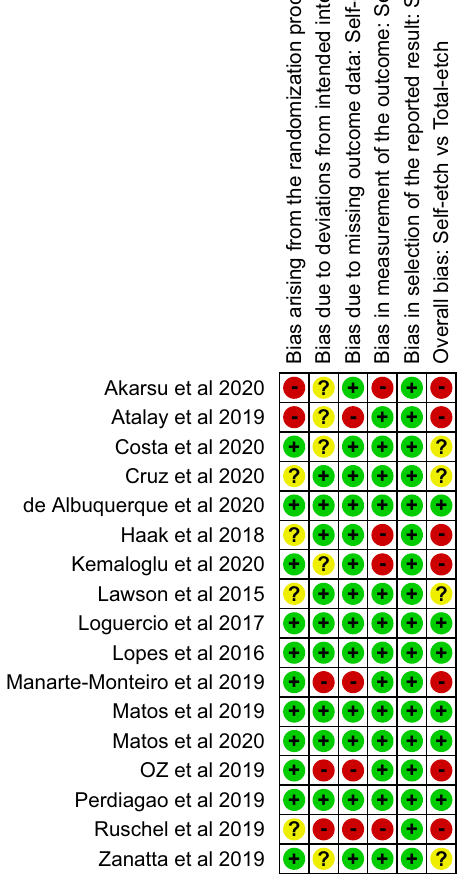
Fig. 3 Risk of bias summary. Graph representing the percentage of bias under each category assessed using Cochrane ’ s risk of bias assessment